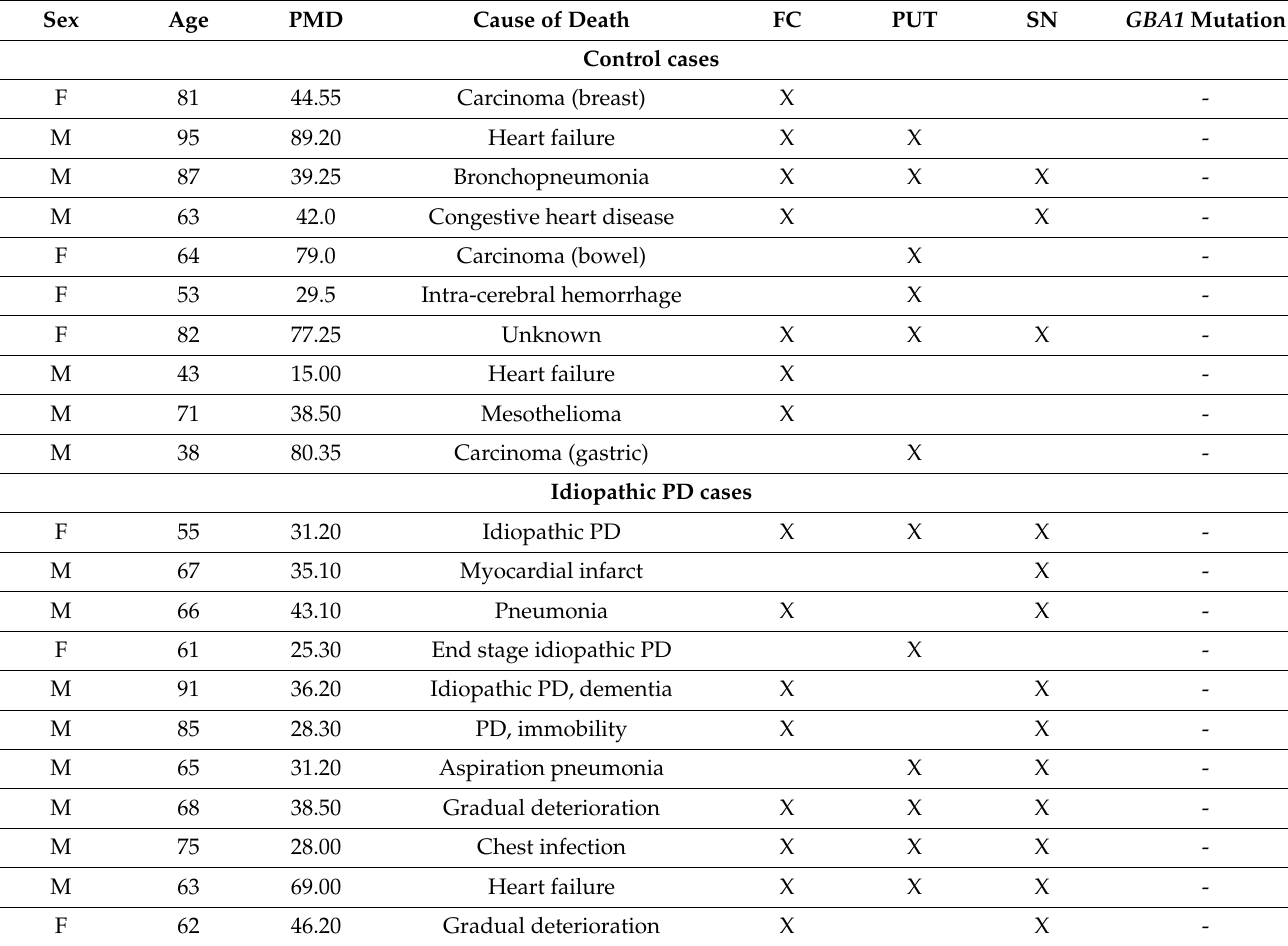
Table 1. Demographic information for all analyzed samples. Legend: PD–Parkinson’s disease, PMD– post-mortem delay, FC–frontal cortex, PUT–putamen, SN–substantia nigra, X–sample pyrosequenced in this